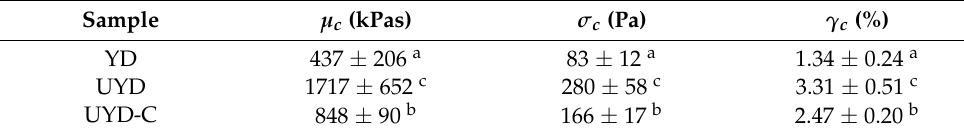
Figure 2. Changes in the apparent viscosity with stress from yield stresses of unyeasted wheat dough (UYD), yeasted wheat dough (YD) and CH-rich unyeasted wheat dough (UYD-C). Table 3. Values of critical viscosity ( µ c ), critical stress ( σ c ) and critical strain ( γ c ) of yeasted wheat dough (YD), unyeasted control wheat dough (UYD) and CH-rich unyeasted wheat dough